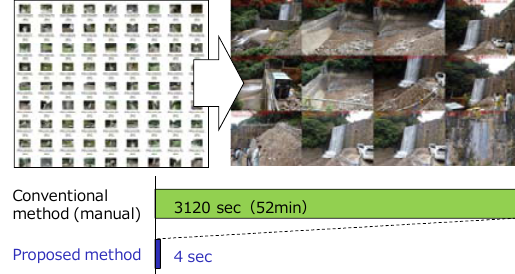
Figure 17. Position and azimuth filtering